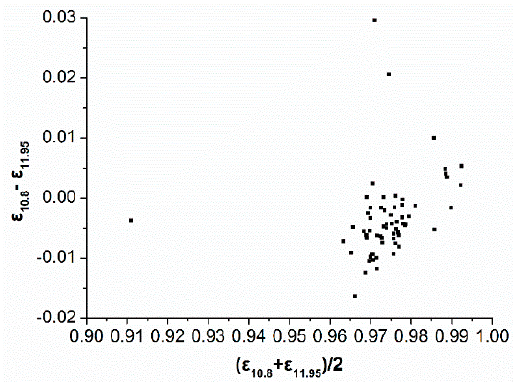
Figure 3. Scatter plot of the channel mean emissivity ( ε 10.8 + ε 11.95 )/2 and channel emissivity difference ( ε 10.8 − ε 11.95 ).